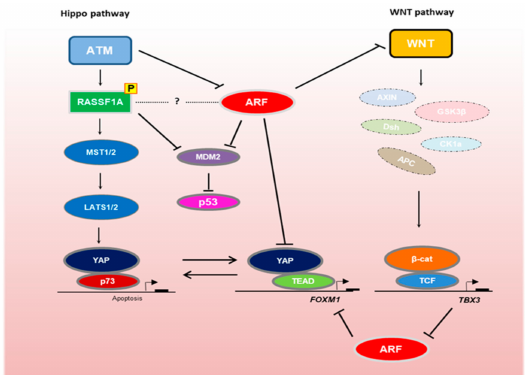
Figure 1. Interplay between the Hippo, Wnt and ARF/p53 signaling pathways in development and tumorigenesis. The Hippo pathway scaffold RASSF1A is activated by ATM-mediated phosphoryla- tion [76,77]. Although ATM inhibits ARF [15], both RASSF1A and ARF prevent MDM2-mediated p53 degradation. RASSF1A activation results in the formation of stable YAP–p73 transcriptional complexes, which drive stem cell differentiation and apoptosis [63,65]. In the absence of RASSF1A, YAP–TEAD complexes drive cellular proliferation via transcription of genes, such as FOXM1 . FOXM1 is inhibited by ARF [70]. ARF also suppresses Wnt signaling [89,90], which upon activation destabi- lizes the β -catenin destruction complex, resulting in β -catenin nuclear translocation and TCF/LEF- mediated transcription of oncogenes, such as TBX3 . TBX3 inhibits ARF to promote oncogenic proliferation